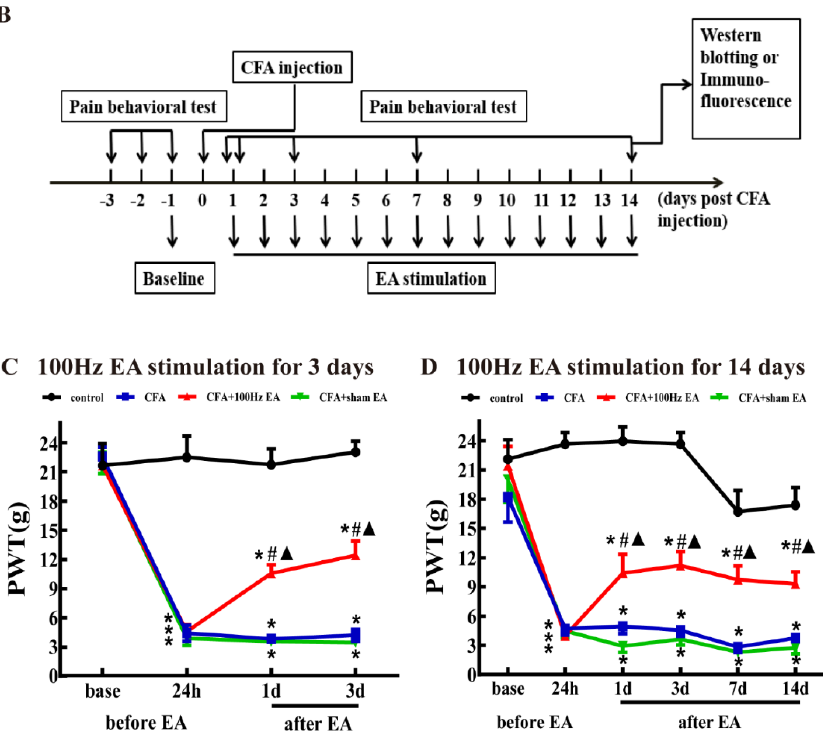
Figure 1. The analgesic effect of 3 days and 14 days 100 Hz electroacupuncture (EA) stimulation on the paw withdrawal threshold (PWT). ( A ) The procedure of short-term (3 days) high frequency EA